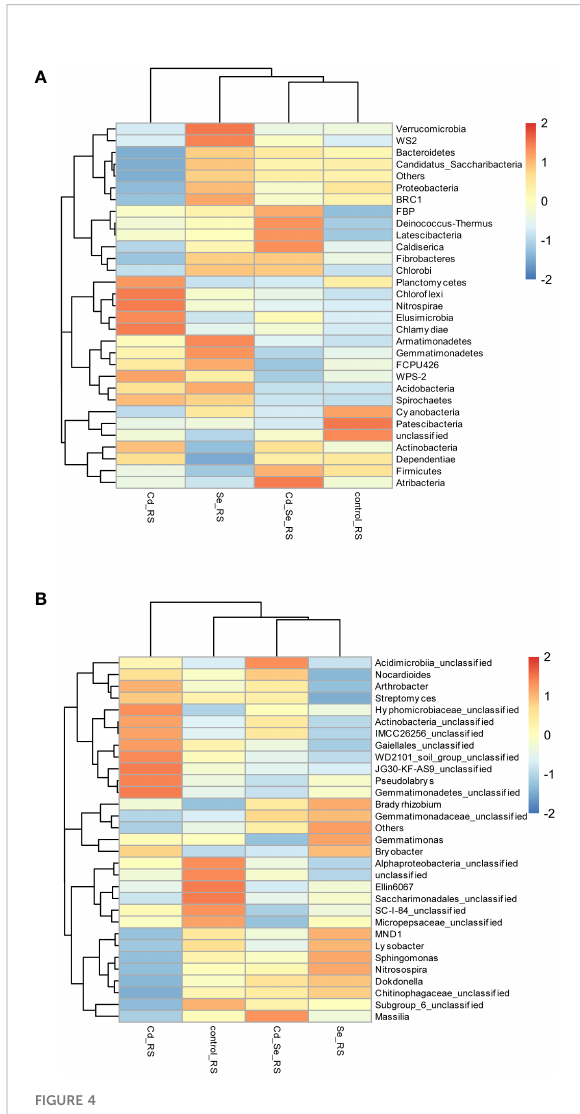
FIGURE 4 Effects of root exposure to Se (1.2 mg/kg) on rhizosphere soil species abundance in perilla under Cd stress (10 mg/kg). (A) Phylum level; (B) Genus